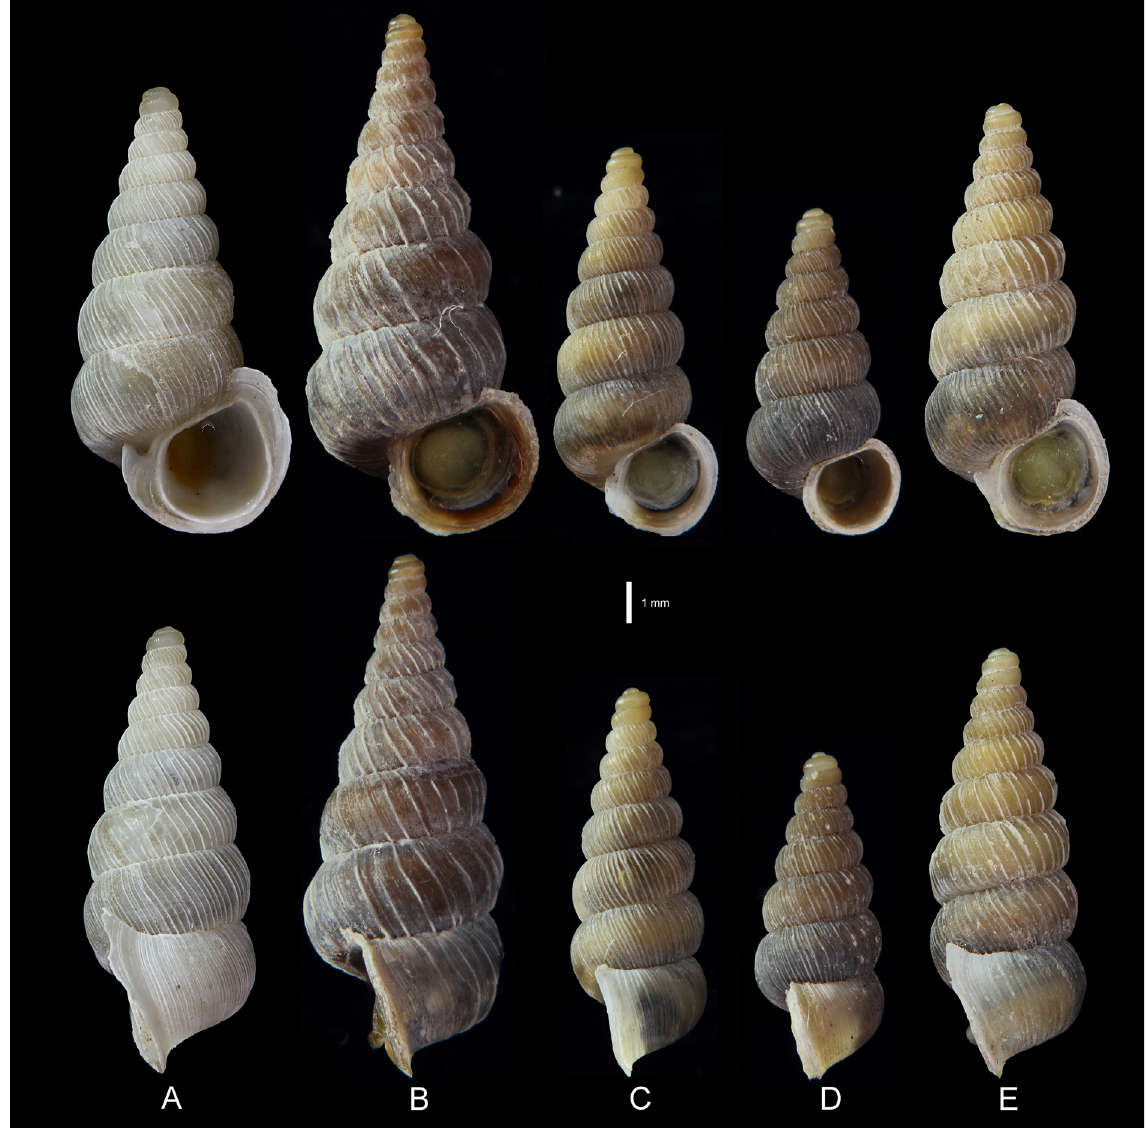
Fig. 5. Female specimens of Cochlostoma (Lovcenia) Zallot et al. , 2015 used for anatomy (shells were destroyed before dissection). A . C. (Lovcenia) erika (A.J. Wagner, 1906) (HNHM 86387). B . C. (Lovcenia) dalmatinum (L. Pfeiffer, 1863) (NHMW 110430/MN/0162). C . C. (Lovcenia) tropo- janum sp. nov. (NHMW 111248). D . C. (Lovcenia) jakschae sp. nov. (NHMW 111249). E . C.